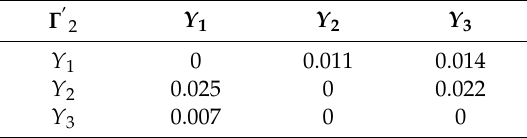
Table 22. The rejoice matrix Γ (cid:48) 2 .